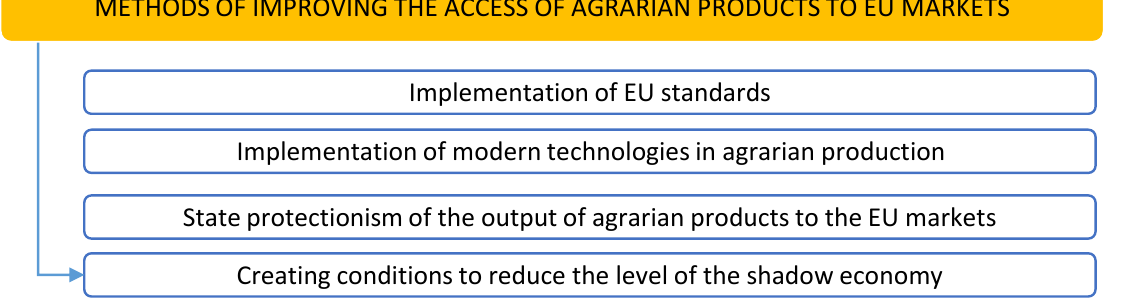
Figure 4. Measures to ensure the sustainable development of the agrarian sector of Ukraine in the process of integration to European